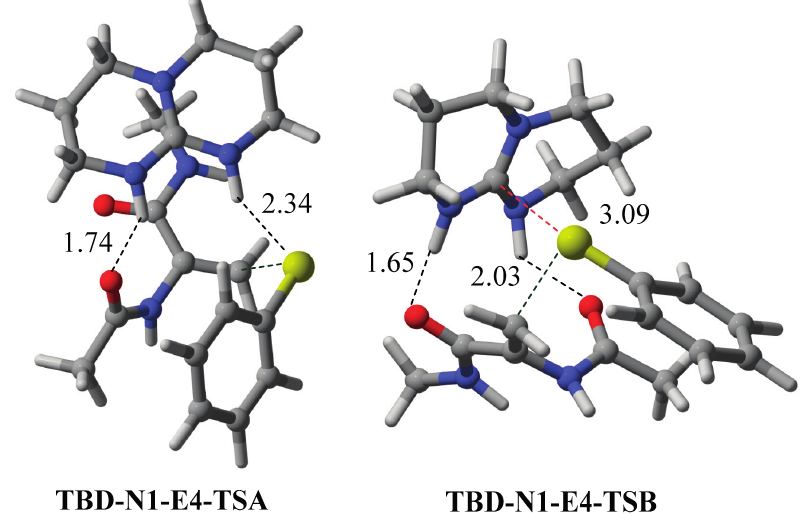
Figure 7. Optimized TSA and TSB transition states for TBD-catalyzed nucleophilic addition between N1 and E4 . Interaction distances are given in